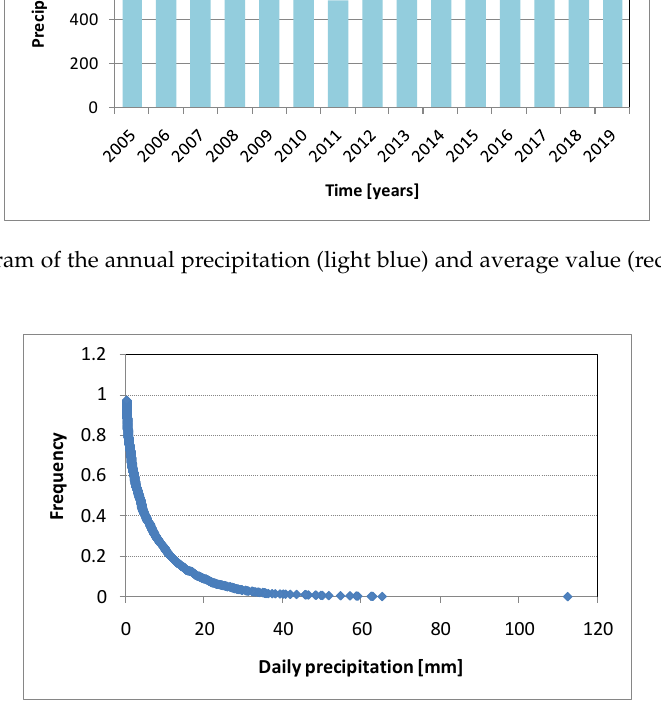
Figure 5. Frequency distribution of daily rainfall for the period 2005–2020.